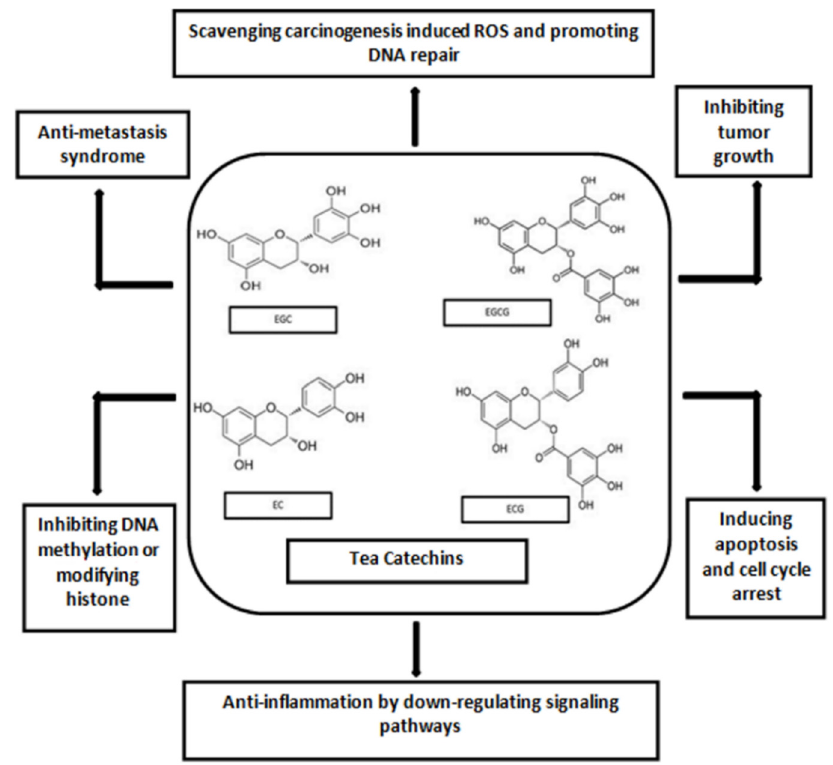
Figure 4. Mechanism of green tea catechins against cancer.